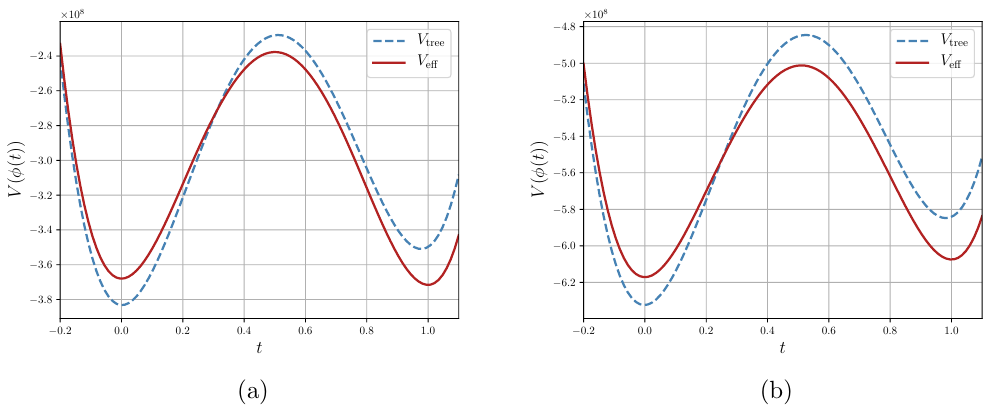
Figure 1. One dimensional slices of the e(cid:11)ective (solid red) and tree-level (dashed blue) scalar potential evaluated at (cid:12)eld con(cid:12)gurations interpolating between the EW and CB minima of the e(cid:11)ective potential. The horizontal-axis represents vacuum con(cid:12)gurations interpolating between the CB and EW vacua. i.e. we interpolate between (cid:30) ( t ) = (1 t ) (cid:30) EW + t(cid:30) CB . Hence, at t = 0, (cid:0) (cid:30) ( t = 0) = (cid:30) EW and at t = 1, (cid:30) ( t = 1) = (cid:30) CB . Figure (a) demonstrates a scenario where V e(cid:11) ( (cid:30) EW ) < V e(cid:11) ( (cid:30) CB ) and (cid:12)gure (b) demonstrates the scenario where V e(cid:11) ( (cid:30) CB ) < V e(cid:11) ( (cid:30) EW ). The values of the VEVs and parameters are given in table